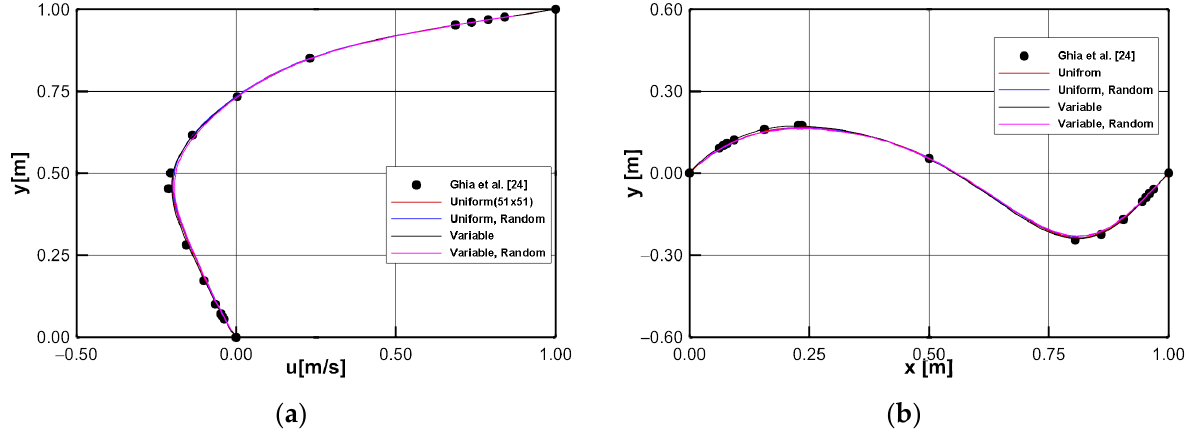
) direction % (cid:152) are depicted in Figure 5, where typical cavity flow patterns can be observed. Figure 6